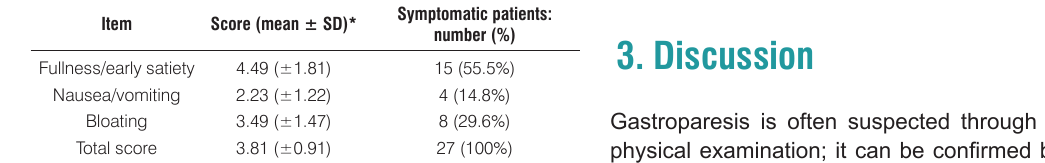
Table 2. Gastroparesis cardinal symptom index results.